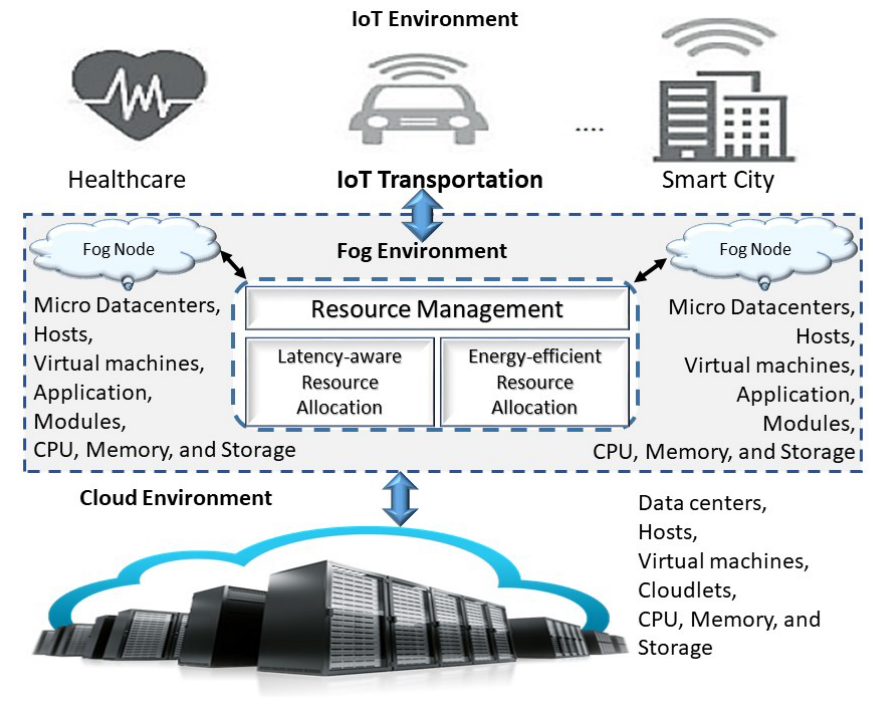
Figure 1. Proposed Model of R2AM.